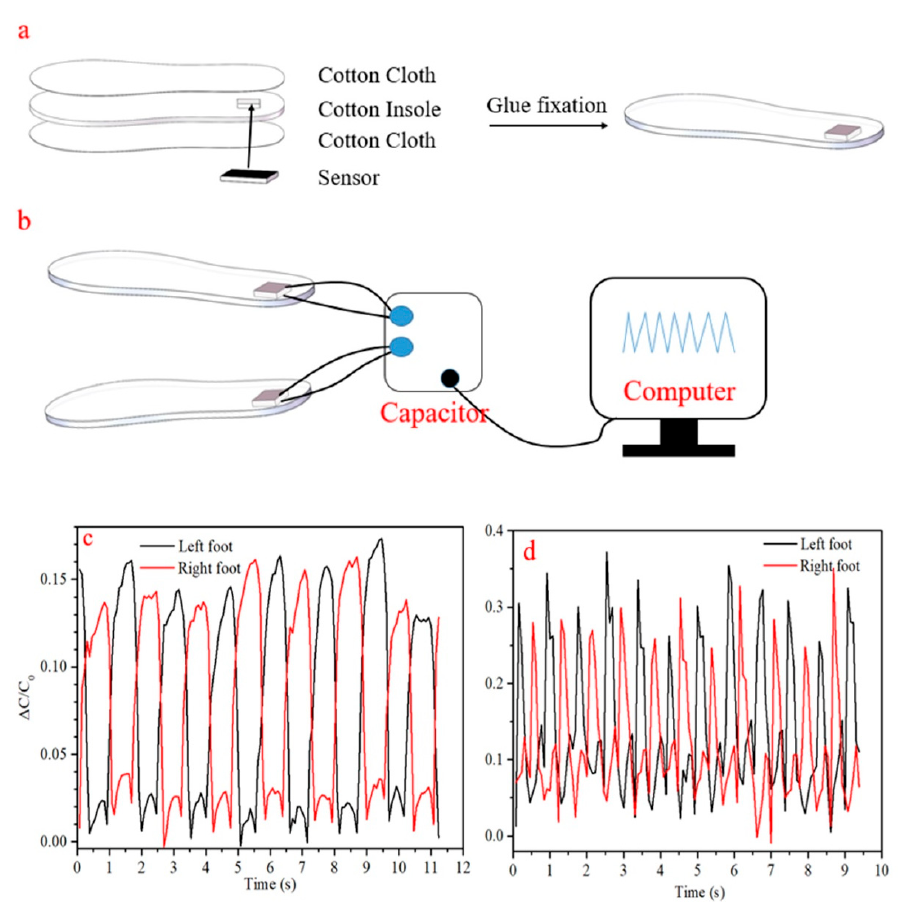
Figure 9. ( a ) Schematic of senor integration in the heal of an insole, ( b ) test circuit diagram for the insole sensor, ( c ) capacitive traces during walking with left and right foot insoles, ( d ) capacitive traces during running with left and right foot insoles.